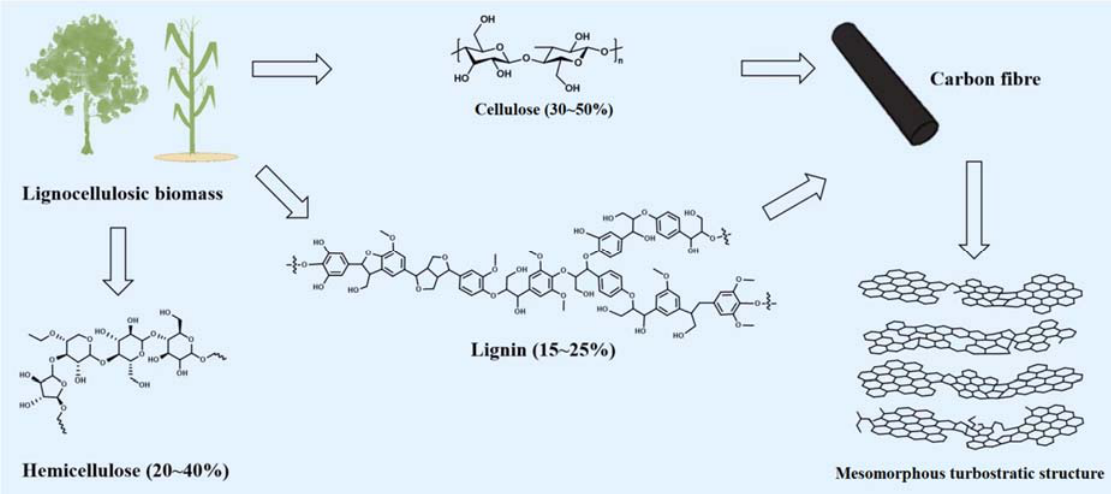
Figure 2. Chemical structures of lignocellulosic biomass and the CFs derived from lignin and cellulose (adapted from Refs. [17,29–32,34,35]).